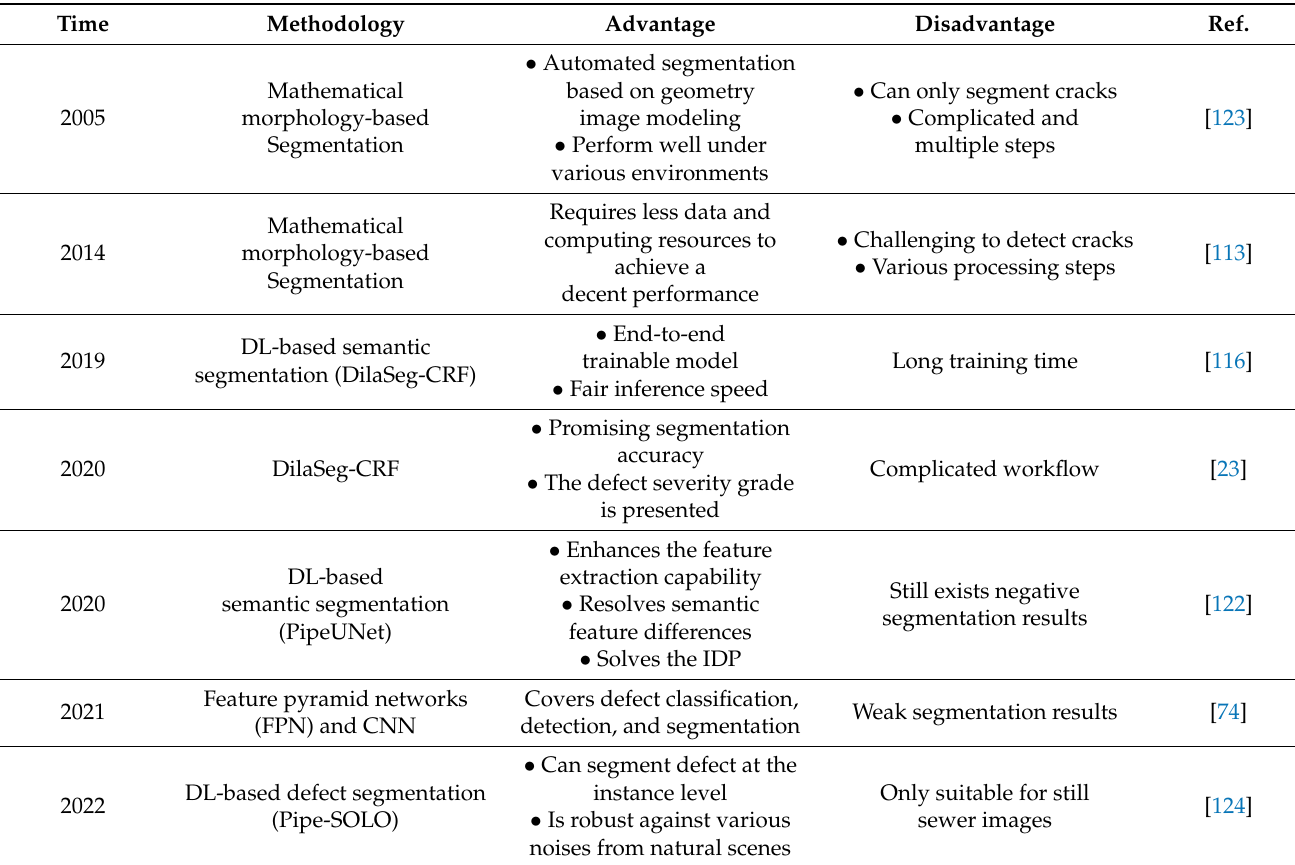
Table 4. Academic studies in vision-based defect segmentation